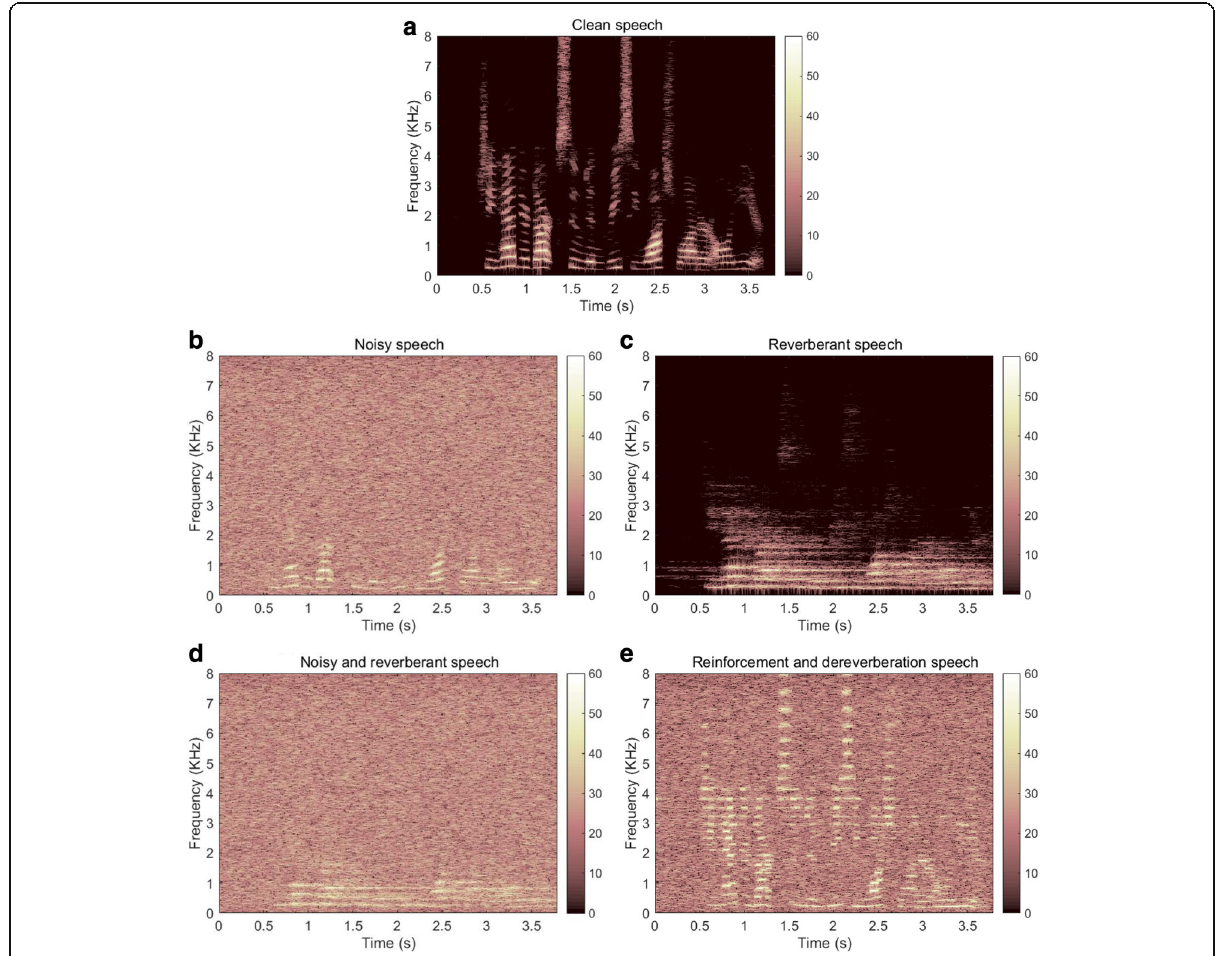
Fig. 4 Spectrogram comparison. a clean speech, b noisy speech (SNR = − 5 dB), c reverberant speech ( T 60 = 3.57 s), d noisy and reverberant speech (SNR = − 5 dB, T 60 = 3.57 s), and e reinforcement and dereverberation speech (SNR = − 5 dB, T 60 = 3.57